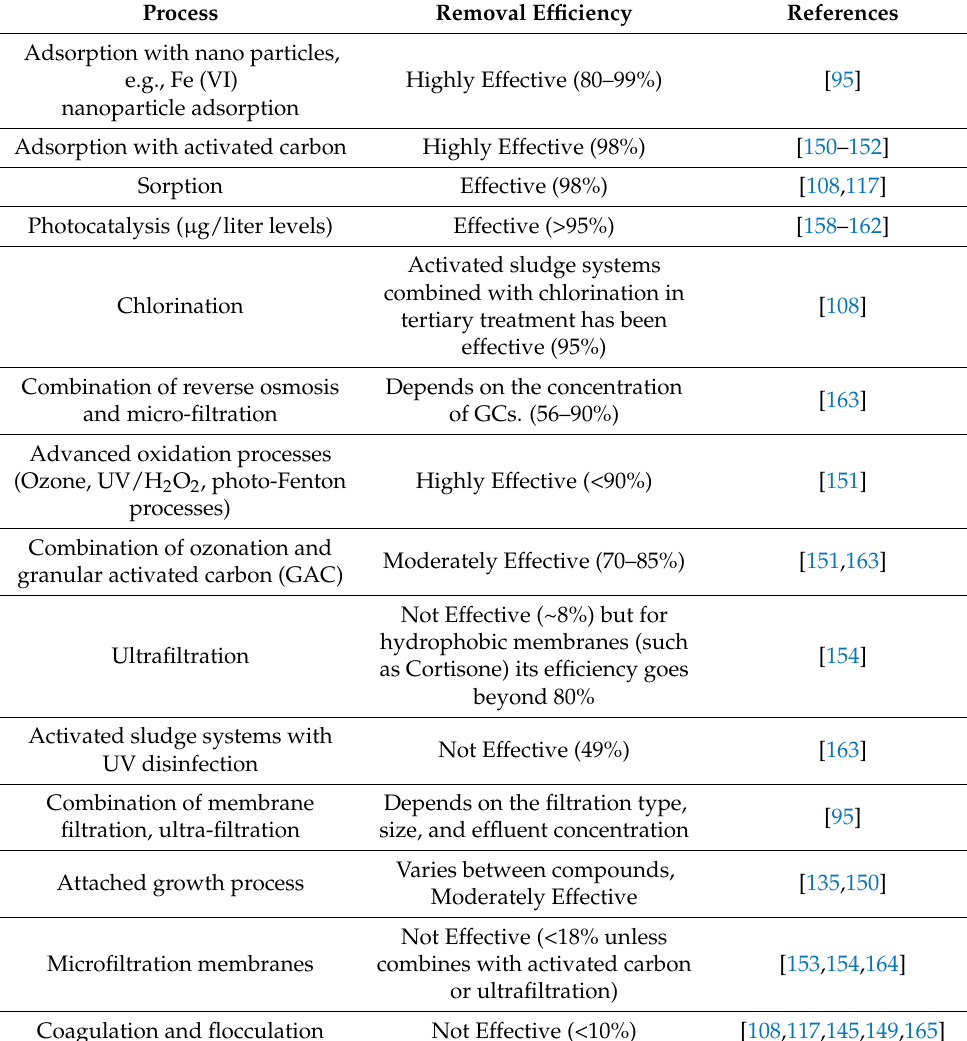
Table 3. Engineering processes and their efficiency for Glucocorticoid’s